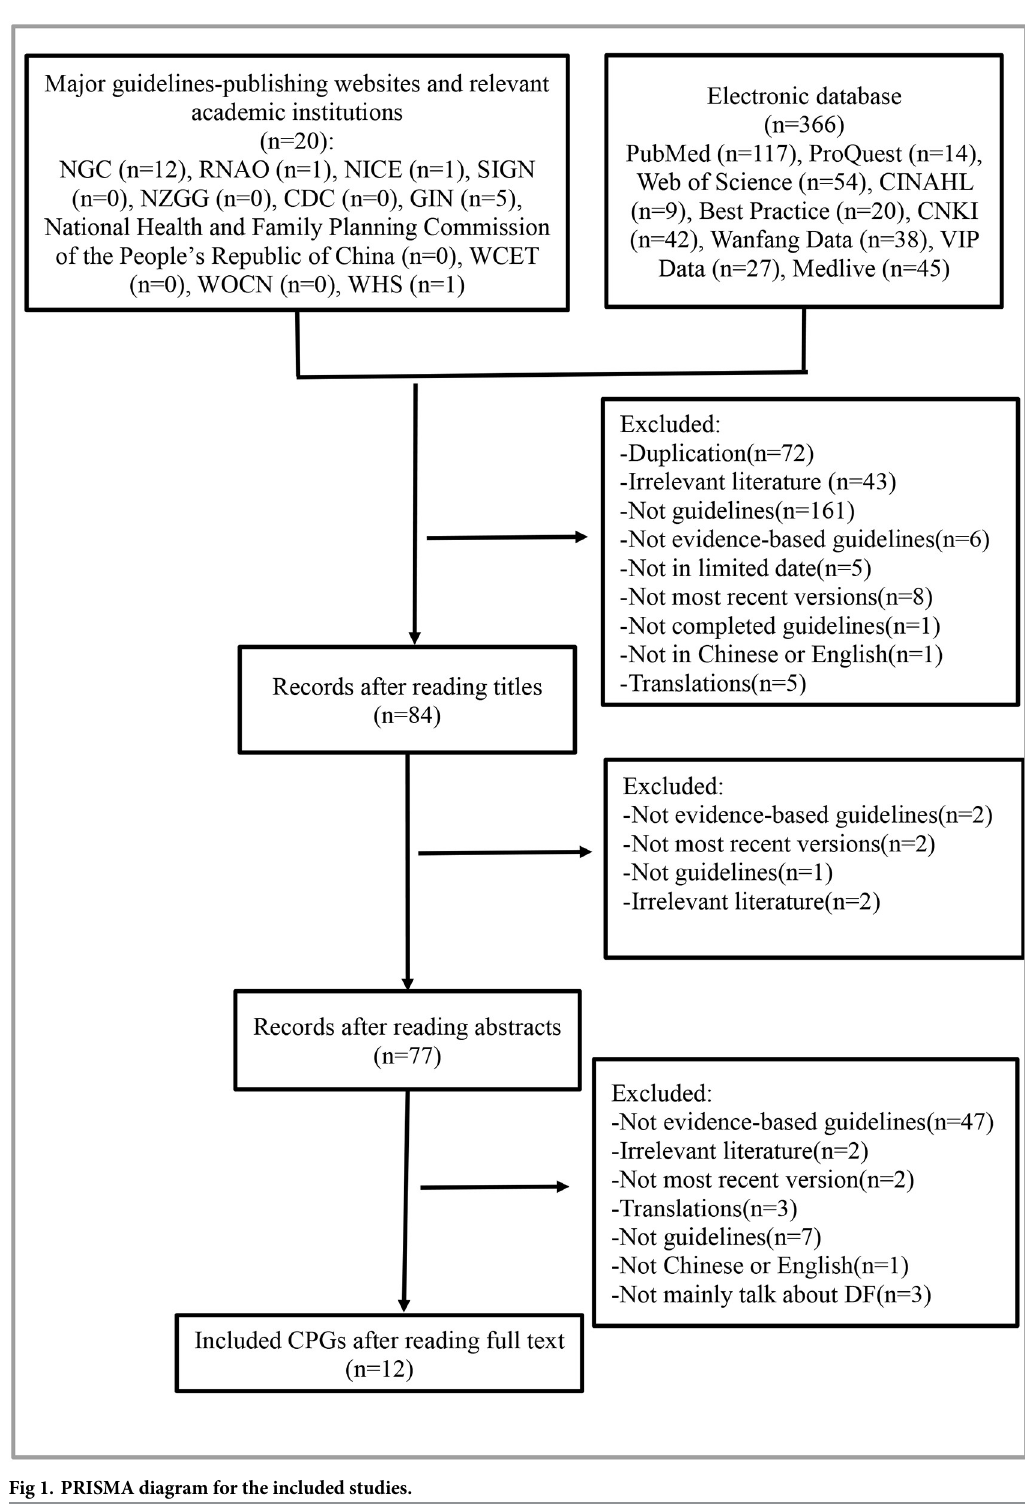
Fig 1. PRISMA diagram for the included studies.